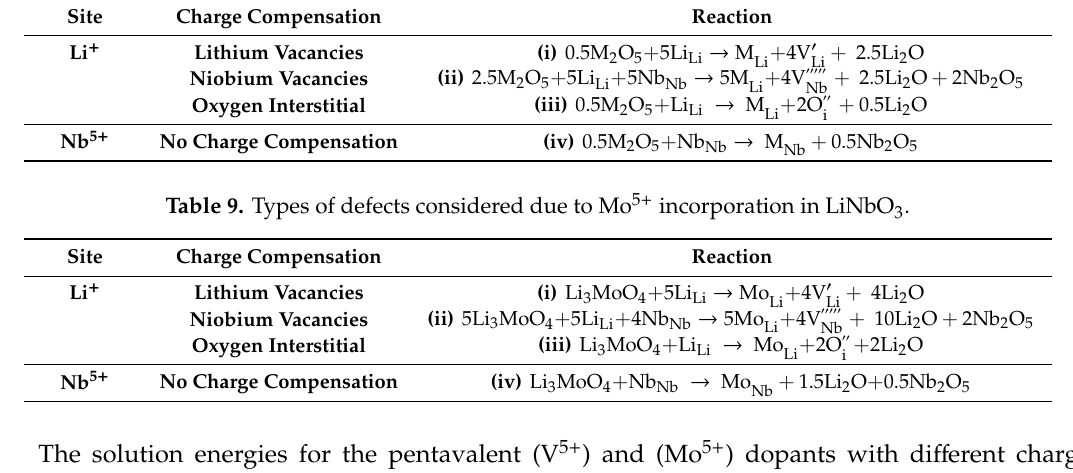
Table 8. Types of defects considered due to M = V 5 + incorporation in LiNbO 3 .